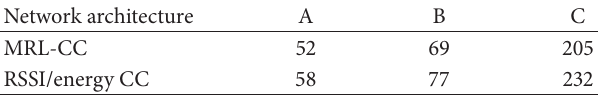
Table 2: Network lifetime (in days) till the first node